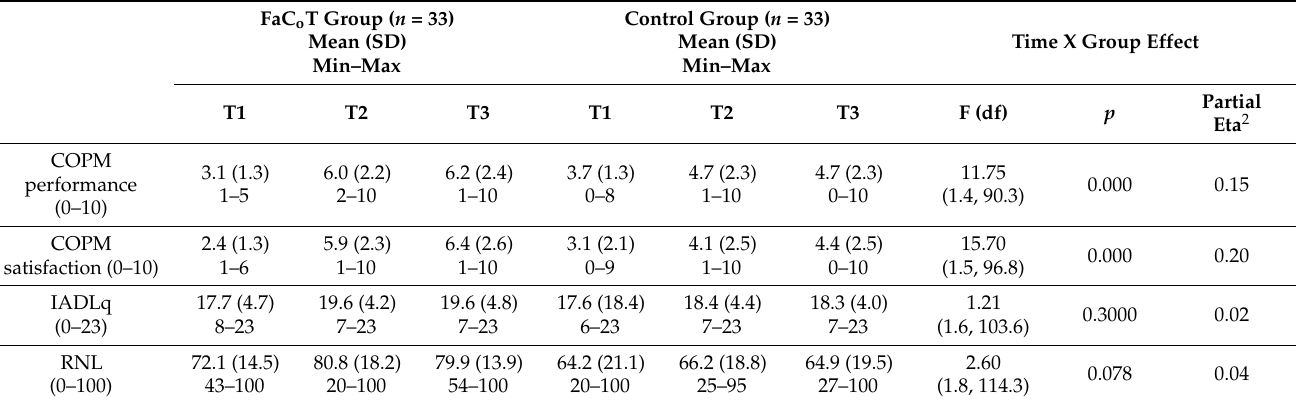
was very large for the FaC o T compared to the control group, especially for the COPM satisfaction. Between T1 and T2, the percent improvement for FaC o T was 207.4% and 241% compared to 39.7% and 55.6% for the control for COPM performance and satisfaction (respectively) (See Table 3). Between T1 and T2, 61% of the participants in FaC o T and 15% of the participants in the control group achieved the MCID for the COPM performance, which was significant ( χ 2 = 14.50, p < 0.0001), and 70% compared with 24% of the participants achieved the MCID for COPM satisfaction ( χ 2 = 13.69, p < 0.000). Between T1 to T3, 61% and 63% of the participants in FaC o T (versus 18% and 31%) achieved a MCID for COPM performance and satisfaction ( χ 2 = 12.44, p < 0.0001, χ 2 = 8.15, p < 0.004, respectively). Table 2. The mean (SD) scores of the PROMs, and Time X Group interaction effect. FaC o T Group ( n = 33) Mean (SD)